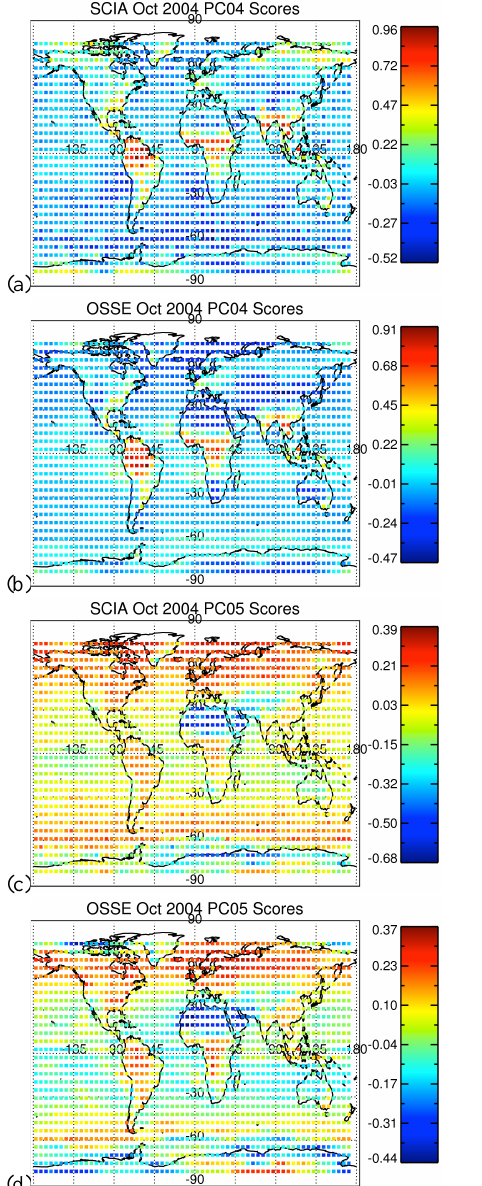
Fig. 5. The spatial distribution of the October 2004 PC4 SCIA- MACHY (a) and OSSE (b) scores and the PC5 SCIAMACHY (c) and OSSE (d) scores. Both PC4 and PC5 scores show evidence of vegetation, implying that this physical signal is distributed between at least these two components. Data set similarities seen in the over- lap of PC shapes in Fig. 4 are reinforced by the similarities seen in the spatial distribution of the scores.